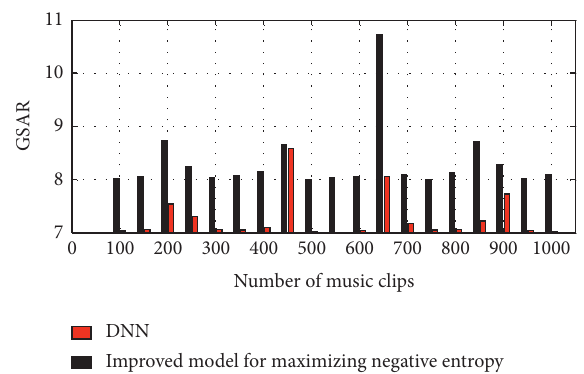
Figure 8: GSAR comparison of the separation results of music fragments in the MIR-1K data